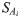
Determination of binding mode diversity.(A) Assignment of possible binding sites. The sequence of the N-terminal 20-residue region of glycogen synthase kinase 3 (GSK3, UniProt P49841) is shown. The possible 5 to 9 residue binding regions of Ser9 are displayed together with their probabilities for disorder-to-order transition (pDORi). (B) Frequencies of binding modes. The distribution of the pDO(R) values for Ser9 are shown. The bimodal distribution of the pDO(R) values indicates that Ser9 can populate both disorder-to-order and disorder-to-disorder binding modes. The interactions with low-density lipoprotein receptor-related protein 6 (LRP6) peptides (wheat) and axin (violet) exemplifies the disorder-to-disorder binding modes (PDB: 4nm5), where the N-terminal region (dashed, cyan) does not adopt a well-defined structure in the complex. Phosphorylation of Ser9 induces folding of the N-terminal peptide (lime), which mediates an auto-inhibitory interaction (PDB: 4nm3)[18]. (C) Shannon entropy for binding modes. The Shannon entropy (Eq 5) is evaluated for the binding mode distribution of each residue. The SAi values predict increased number of possible binding modes for residues 7–11, which is consistent with their conditional folding.